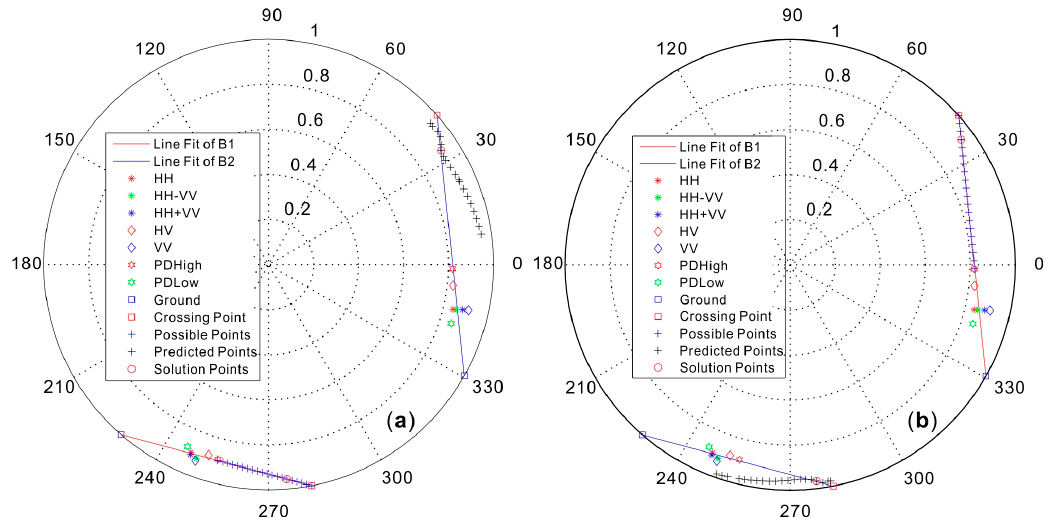
Figure 4. One example of inversion scenario for the SBPI and DBPI methods in the unit complex plane. ( a ) Image 1-2 as the first baseline B with DBPI; ( b ) Image 1-3 as the first baseline 1 ( a ) Image 1-2 as the first baseline B 1 with DBPI; ( b ) Image 1-3 as the first baseline B 1 with